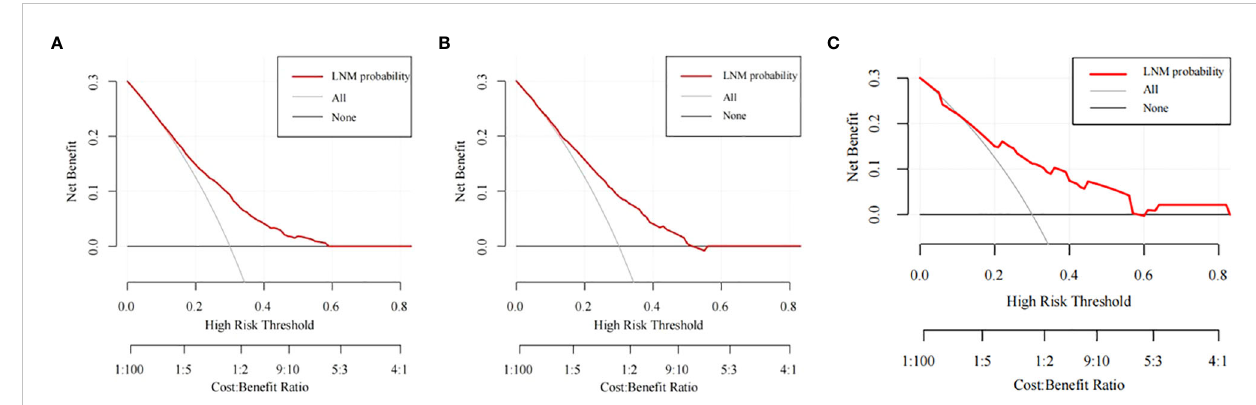
FIGURE 6 The DCA curves of the nomogram for predicting the LNM in the training cohort (A) , the internal validation cohort (B) , and the external validation cohort (C) .